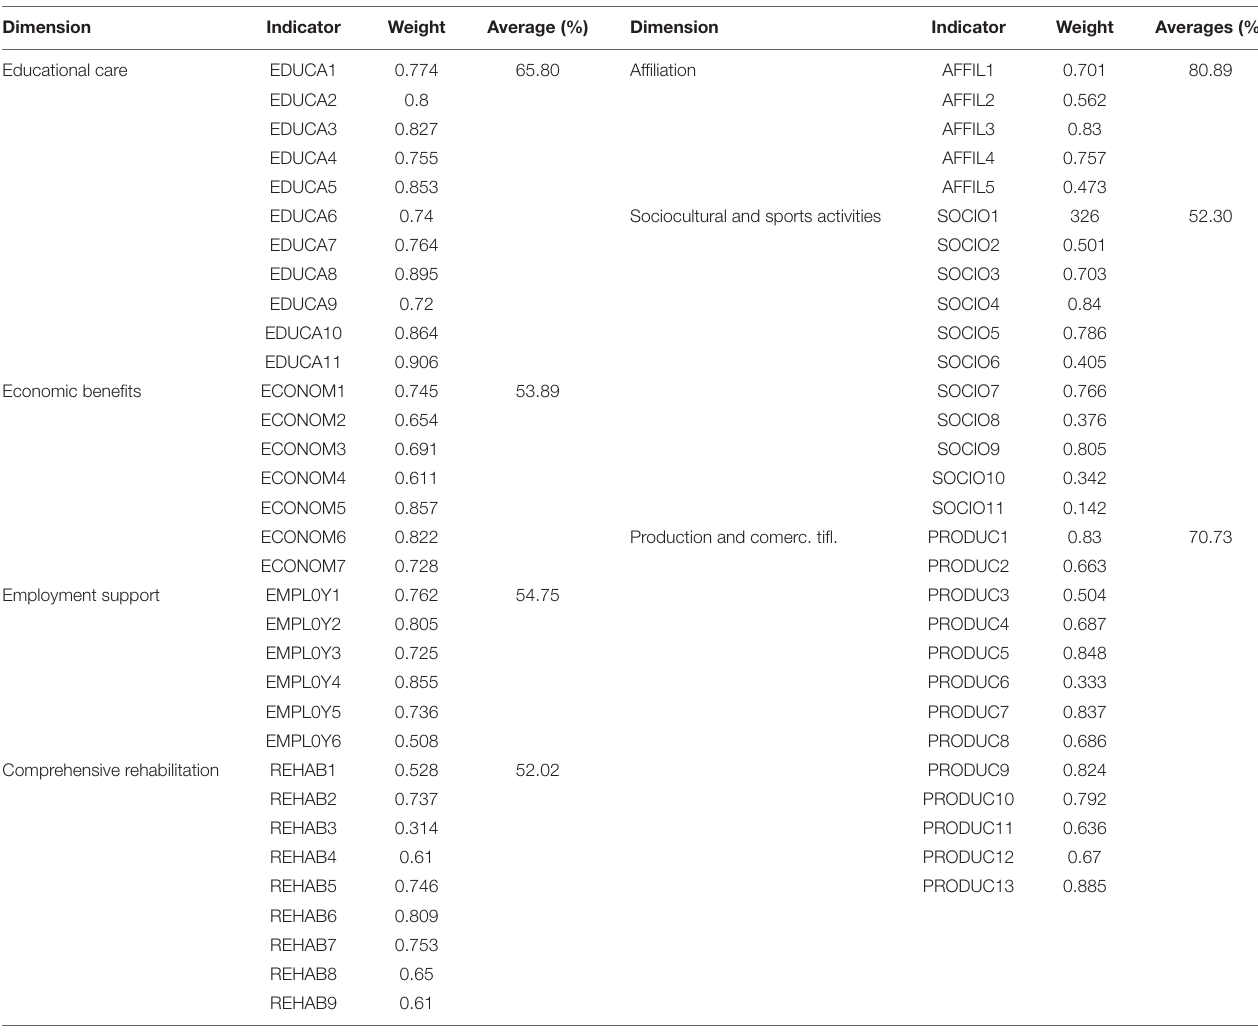
TABLE 4 | Exploratory factor analysis results of each dimension. Dimension Indicator Weight Average (%) Dimension Indicator Weight Averages (%)